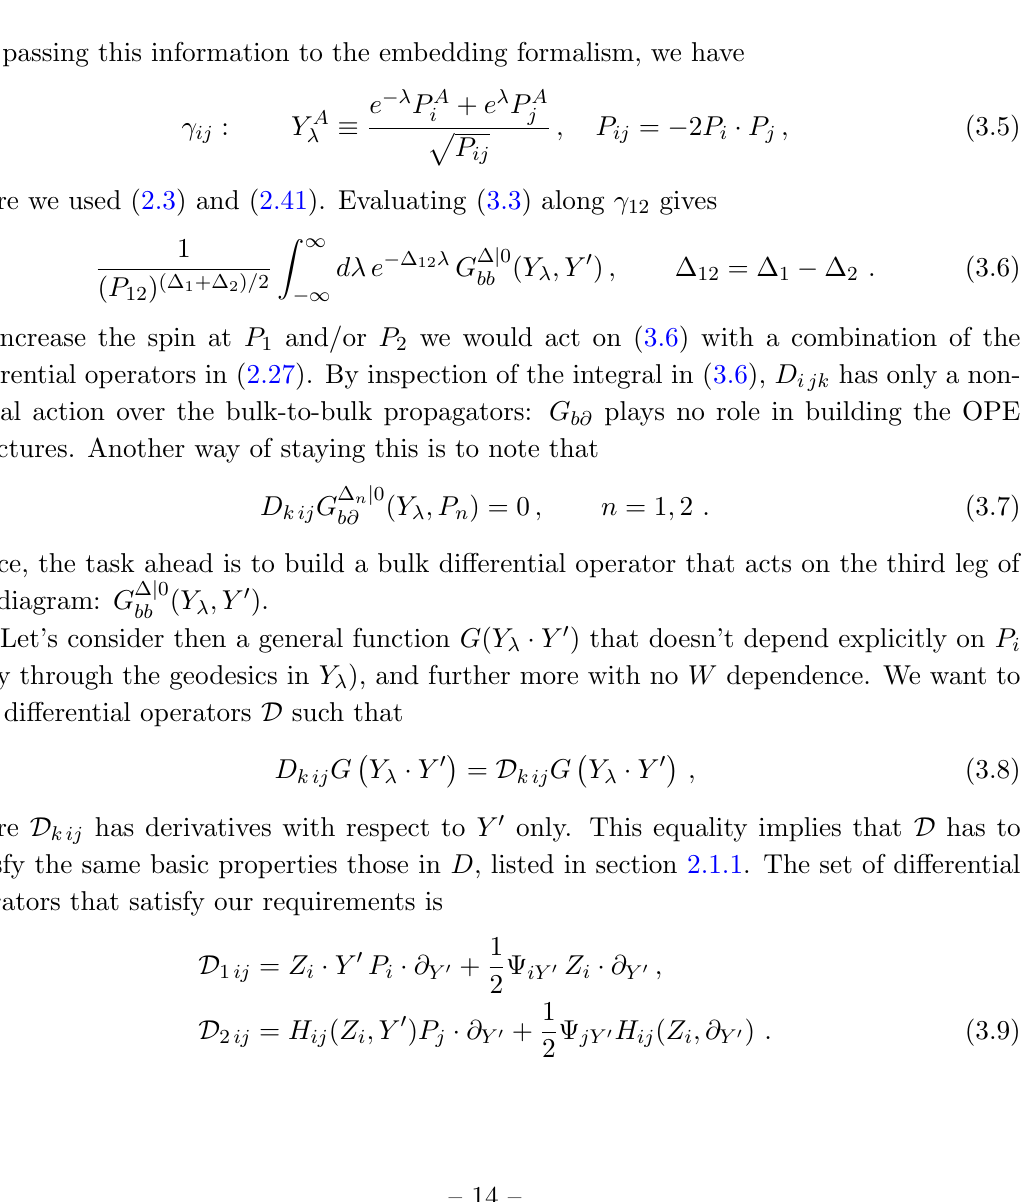
Figure 2 . A precursor diagram where two legs are in the boundary and one in the bulk. This type of object appears at intermediate steps when evaluating conformal